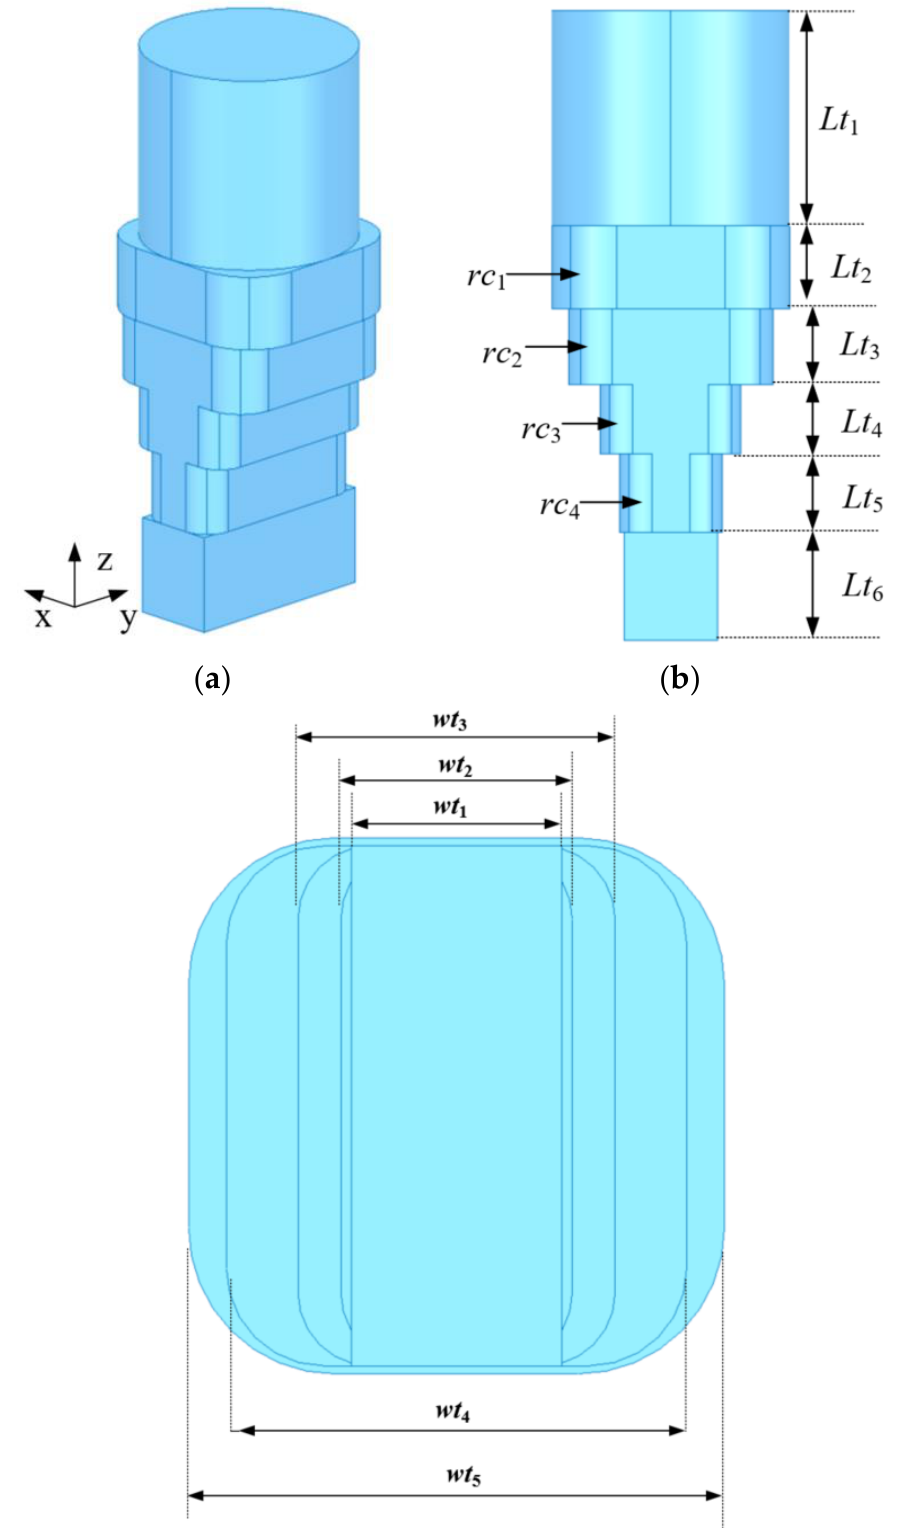
Figure 9. Internal structure diagram of the waveguide converter: ( a ) Isometric view. ( b ) Front view. ( c ) Bottom view.